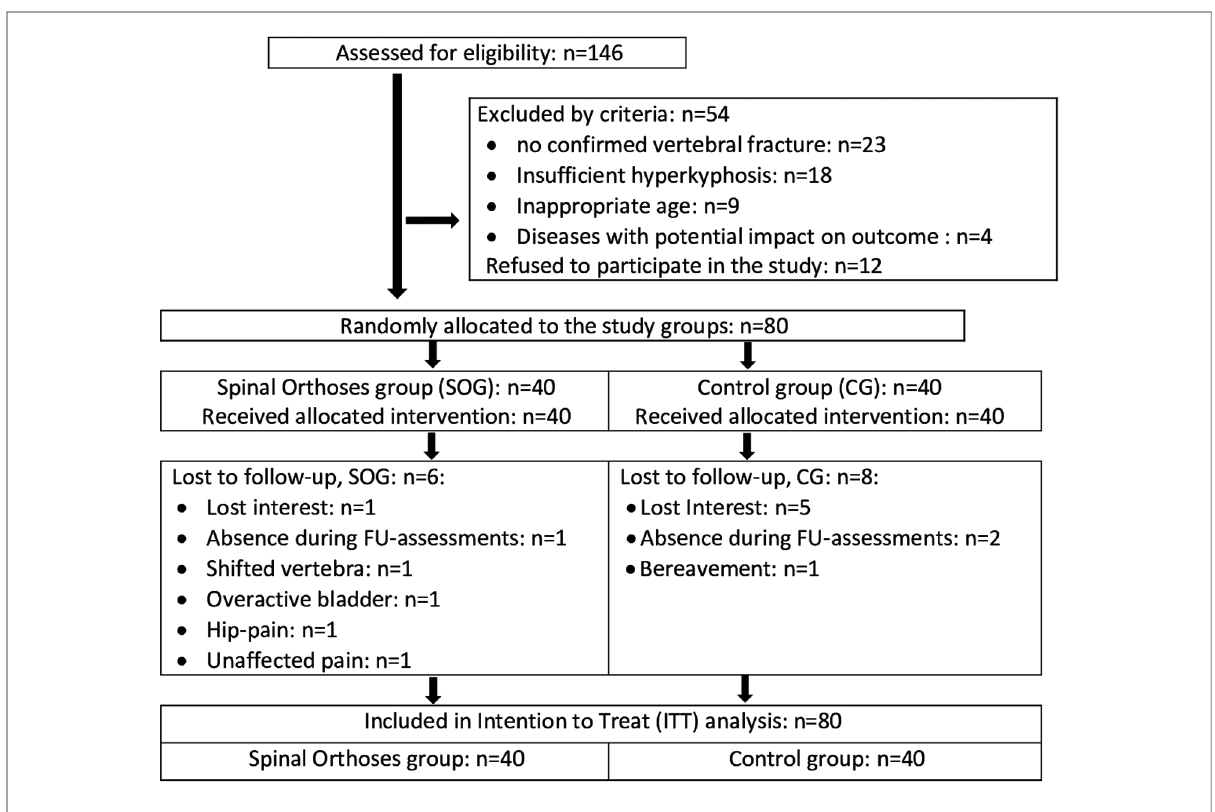
FIGURE 3 Participant fl ow through the present